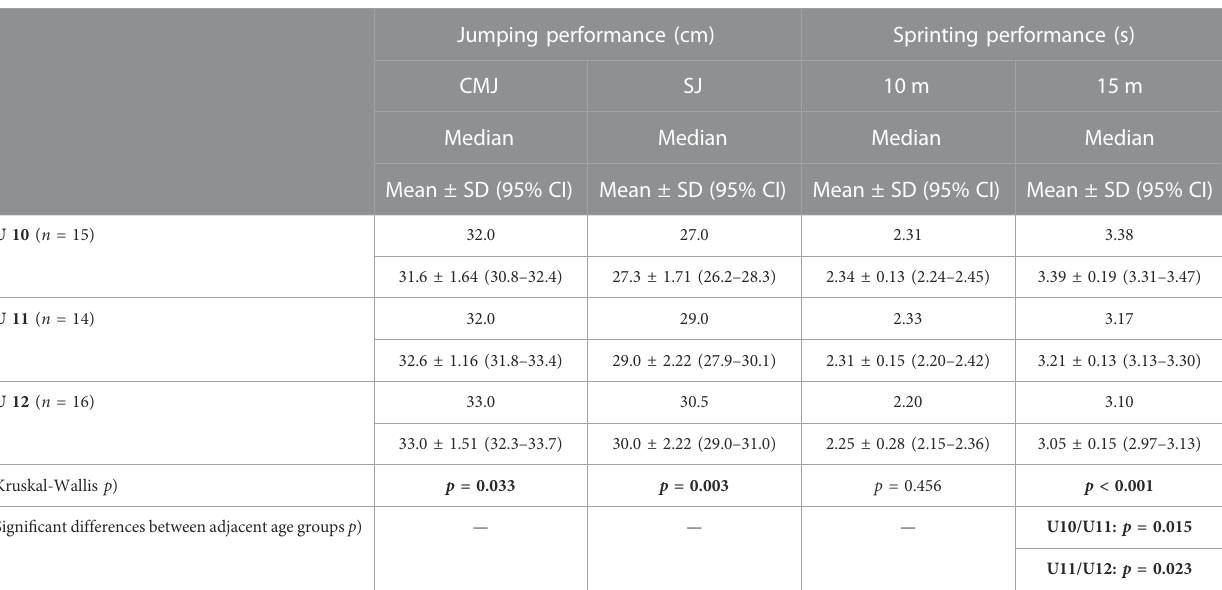
TABLE 4 Jumping and sprinting performance in relation to age